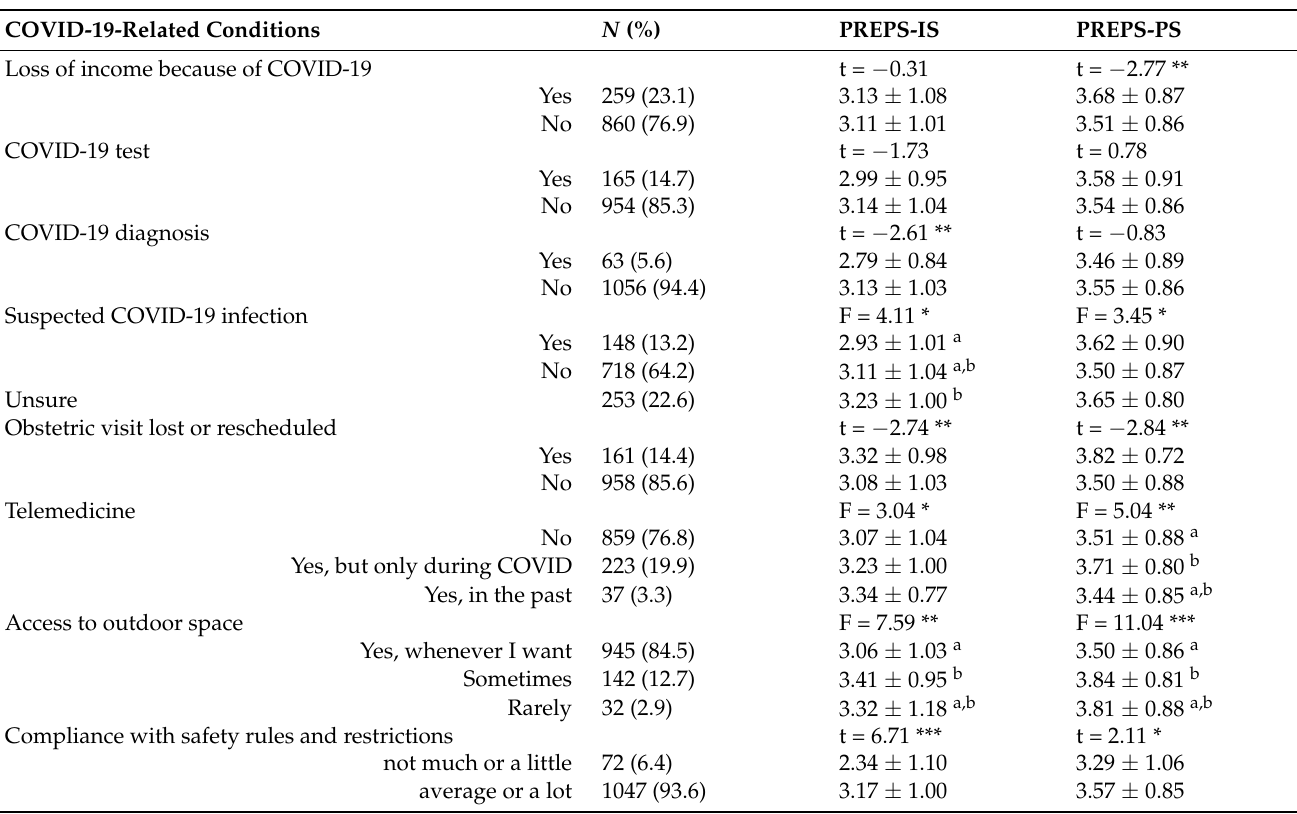
Table 2. Sample characteristics and mean differences in PREPS-IS and PREPS-PS scale score based on COVID-19-related conditions ( N =